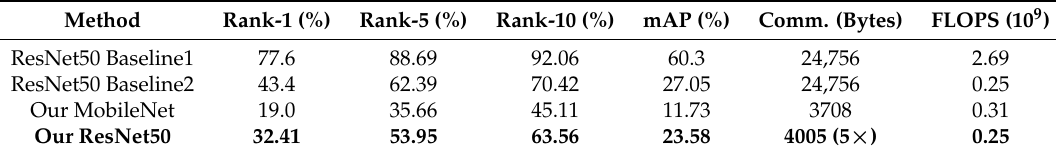
Table 8. Comparison with the baseline using